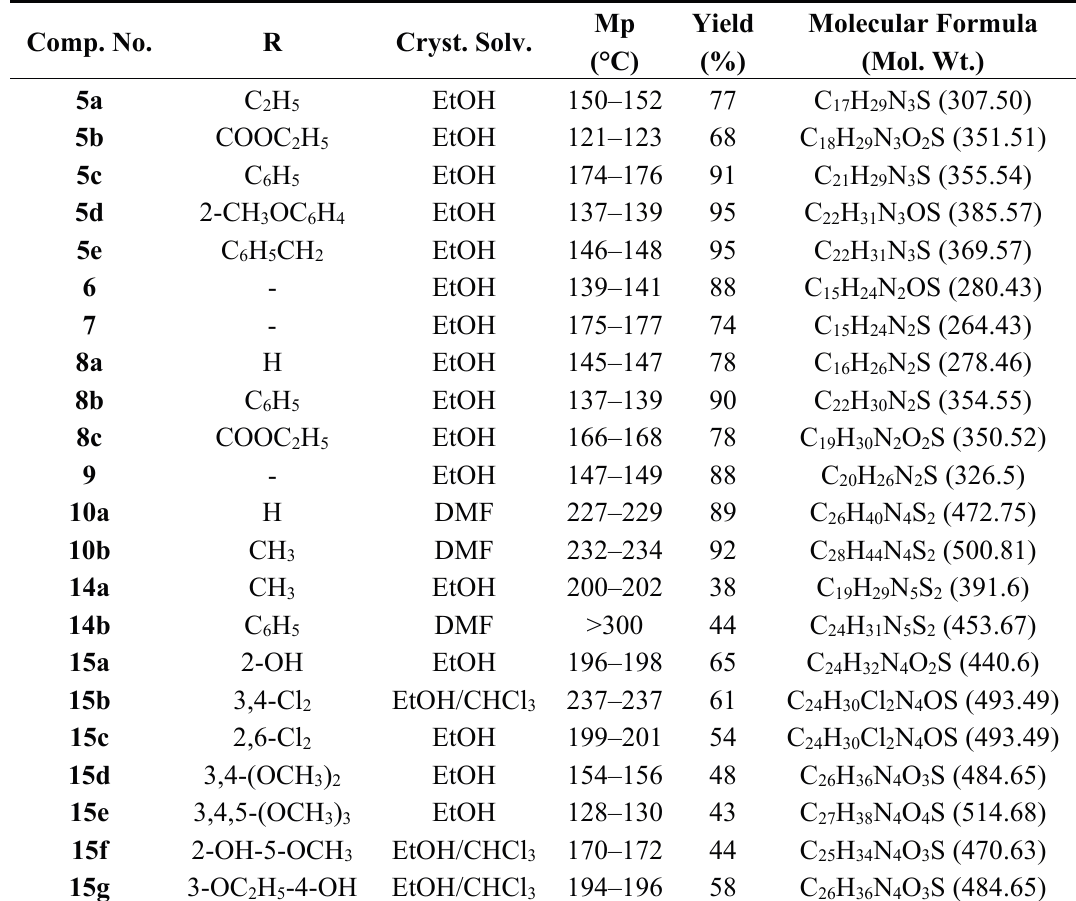
Table 1. Crystallization solvents, melting points, yield percentages, molecular formulae and molecular weights of compounds 5a – e , 6 , 7 , 8a – c , 9 , 10a , 10b , 14a , 14b and 15a – g . Comp.